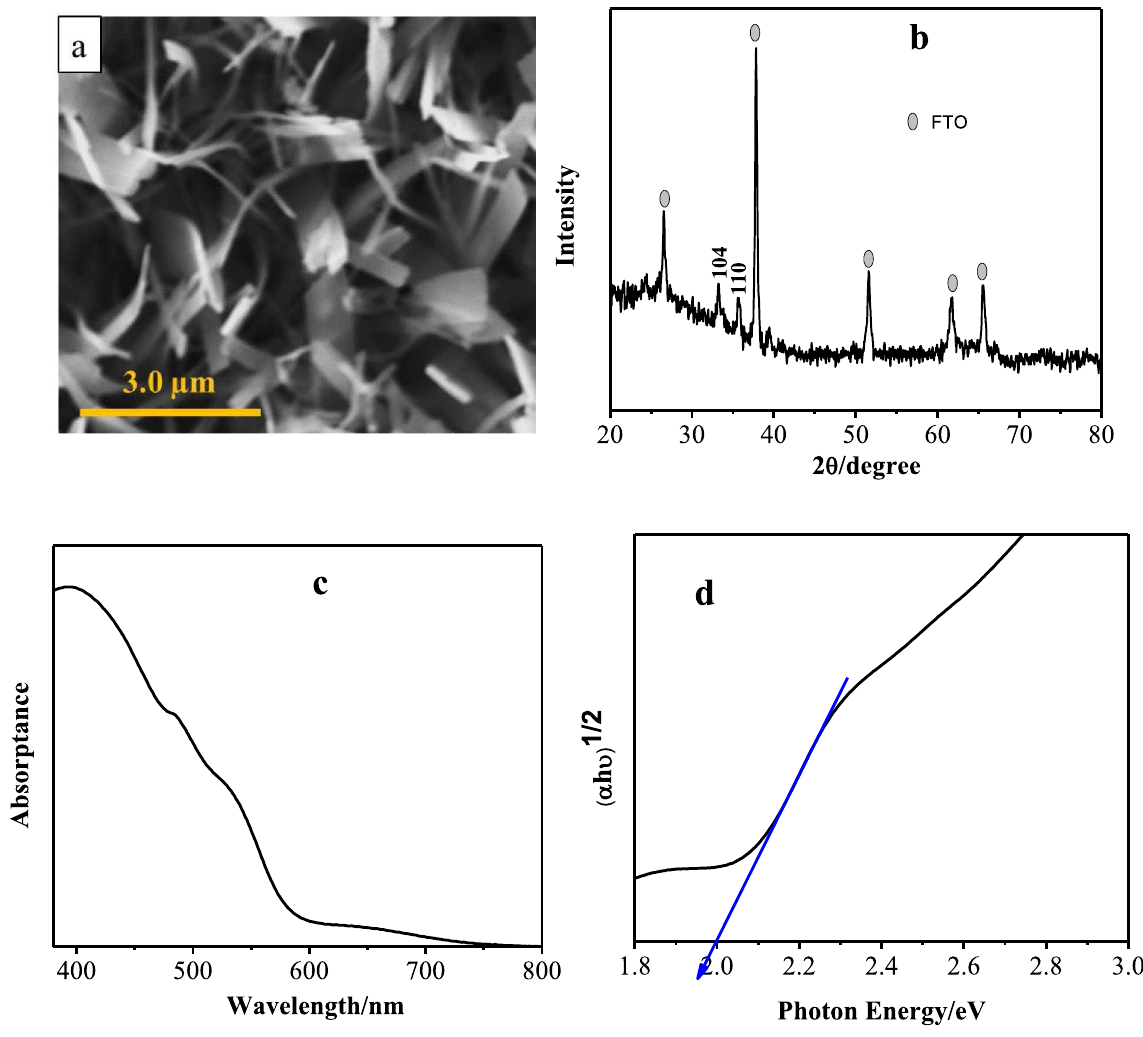
Fig. 2 Characterizations of hydrothermally synthesized Fe sis, c UV–vis absorption spectrum, d Tauc plot for the as-synthesized Fe